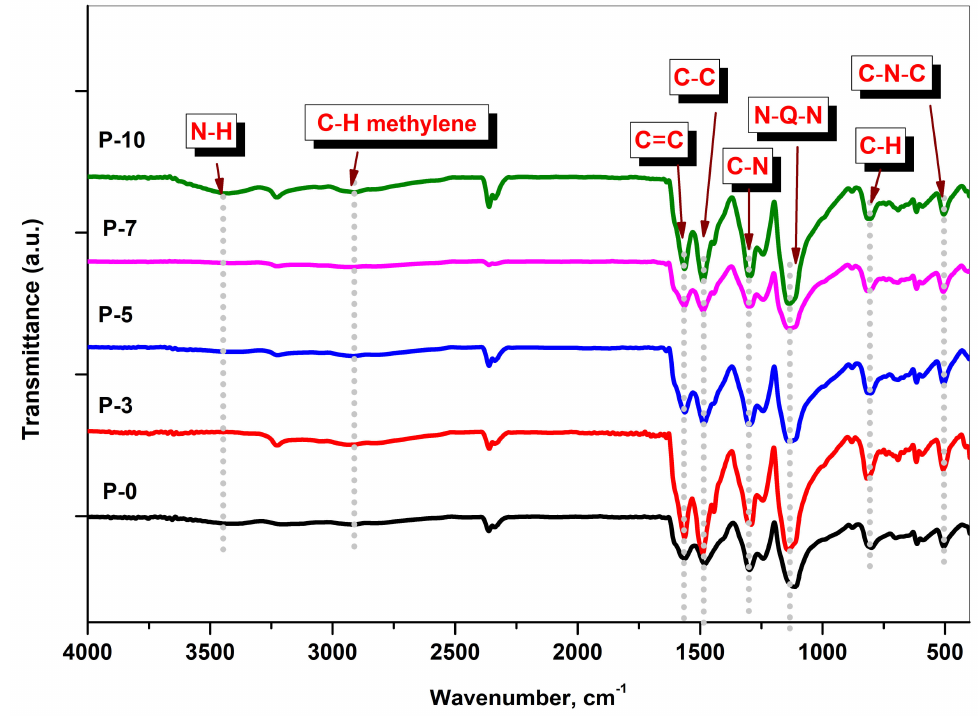
Figure 3. FTIR spectra of the investigated PANI/MWCNT